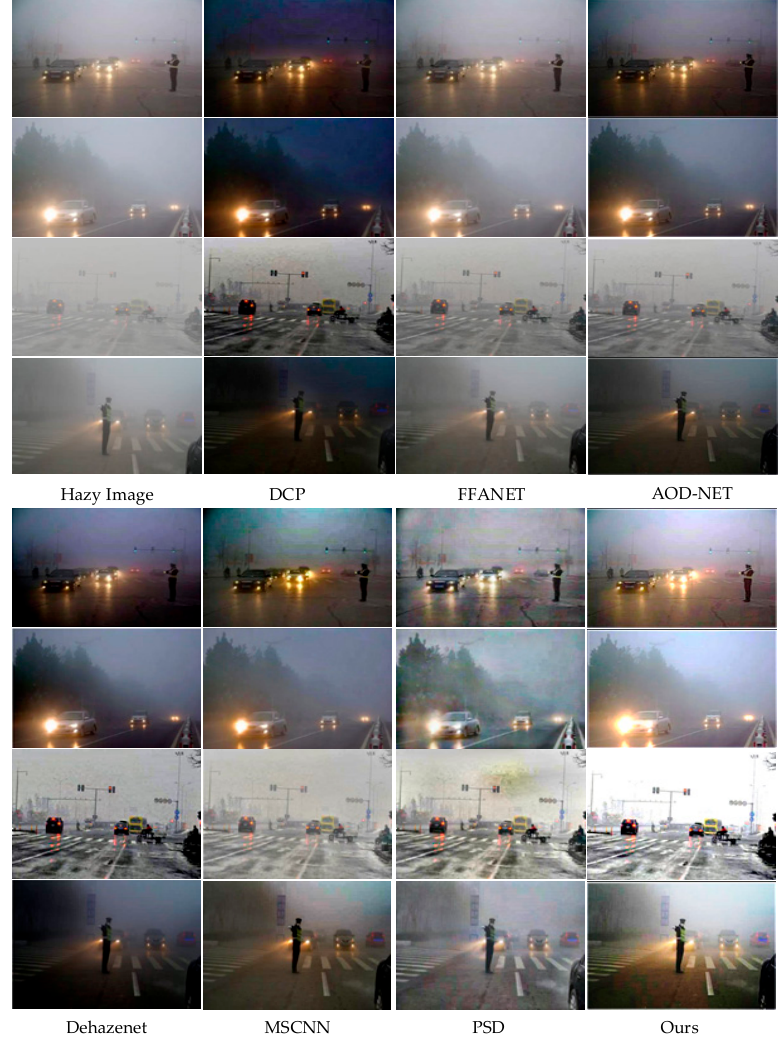
Figure 5. Qualitative comparison of different methods on low-light foggy traffic images. Table 2. Quantitative evaluations on the benchmark dehazing datasets. ↑ and ↓ mean the better meth- ods should achieve higher/lower score of this